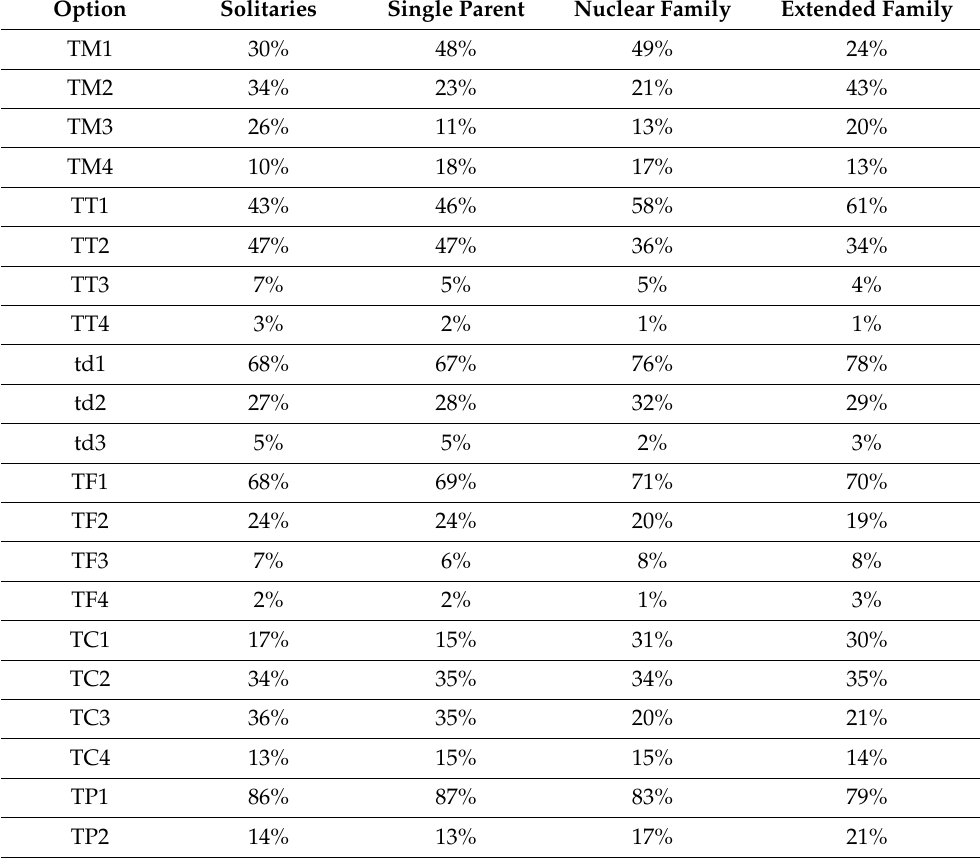
Table 5. Priorities of TBCs from the lens of family structure groups.